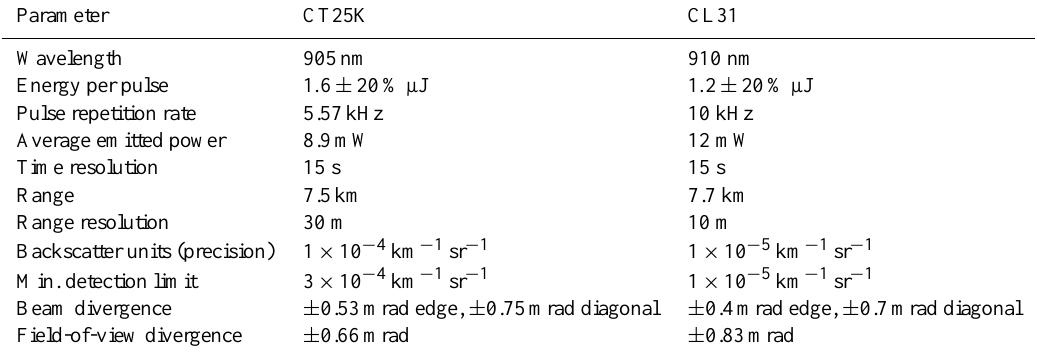
Table 1. Technical specifications of CT25K (Summit) and CL31 (PE)